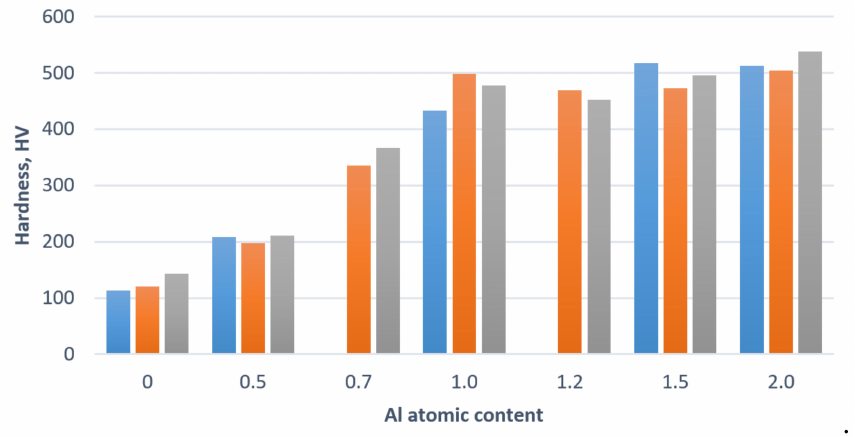
Figure 2. Effect of aluminium content on hardness of Al x CoCrFeNi alloys (blue—based on [56], orange—based on [57], grey—based on authors’ own unpublished research